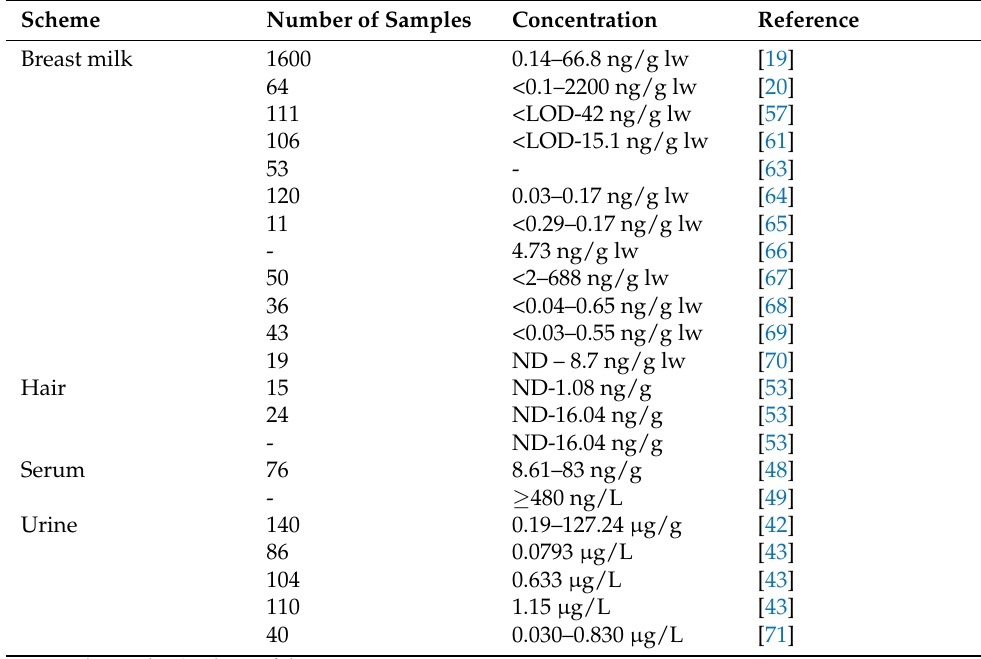
Table 1. Detected concentrations of TBBPA in human